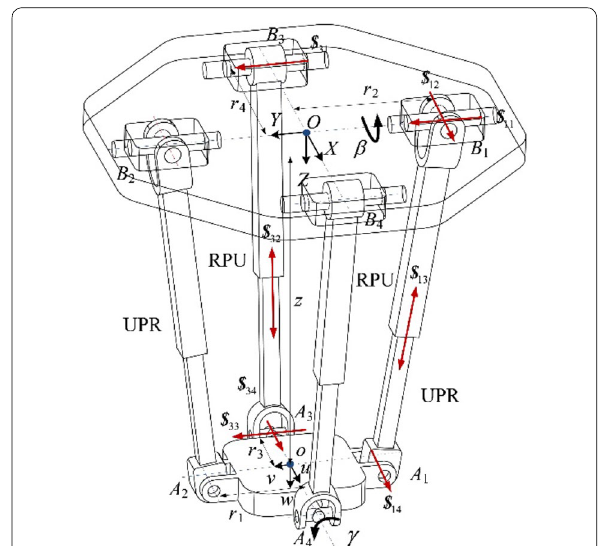
Figure 2 CAD model of a 2UPR-2RPU parallel